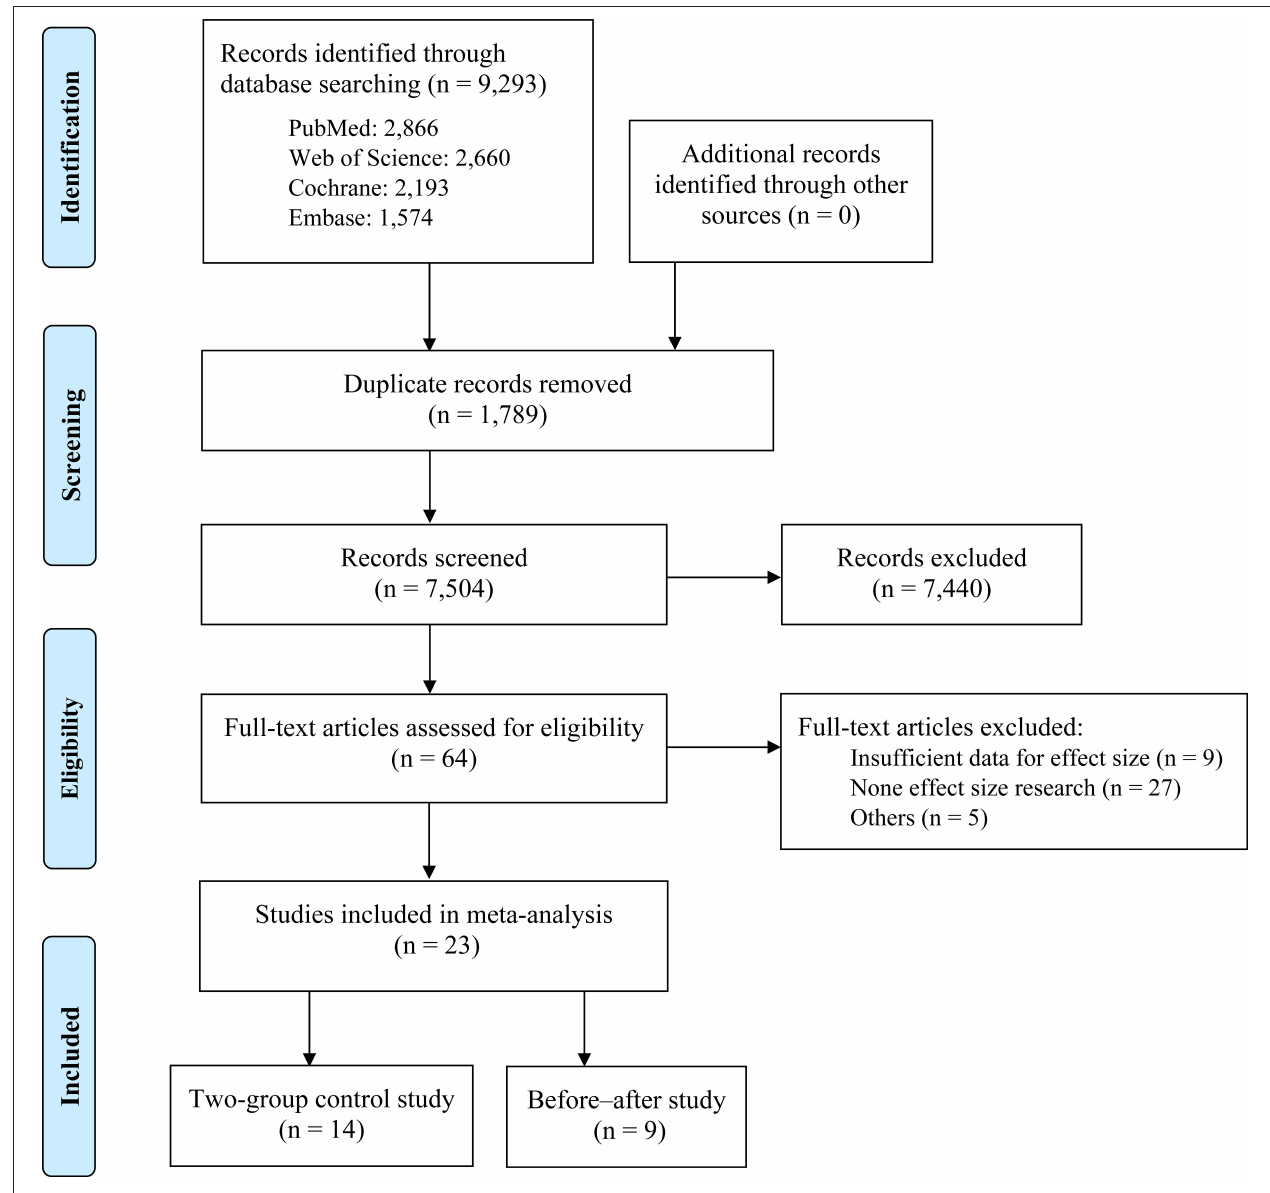
FIGURE 1 | PRISMA